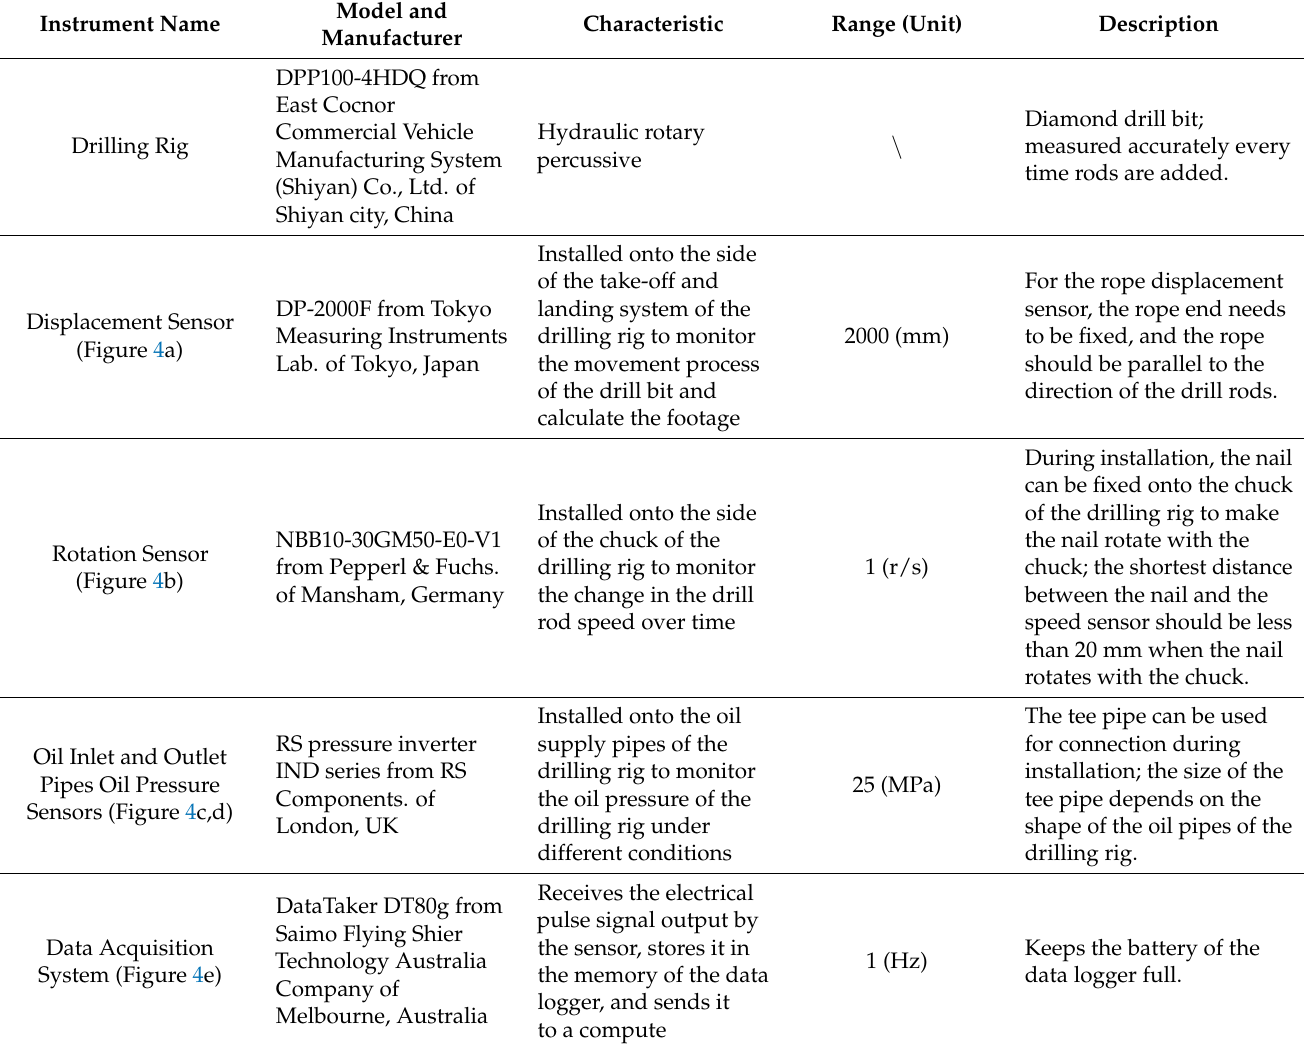
Table 1. The instrument used in the drilling test in Yan’an